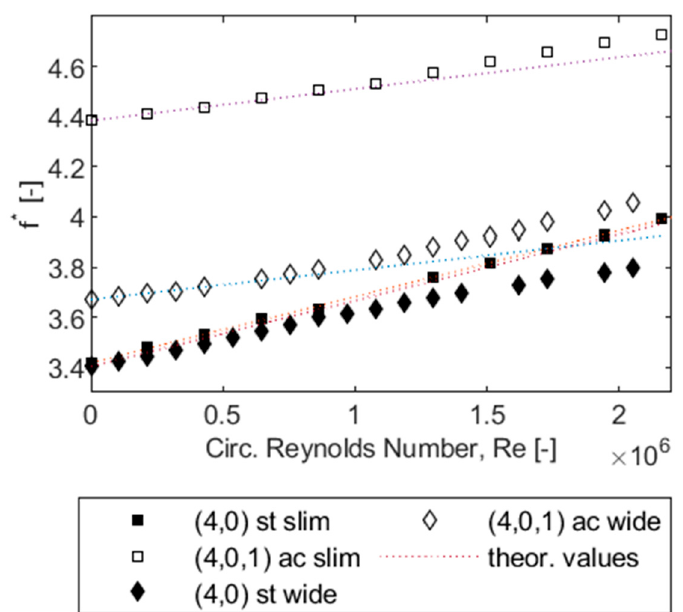
Figure 11. Normalized natural frequencies of forward waves of four nodal diameter mode pair in air at 0.1 MPa for “wide” and “slim cavity” over circumferential Reynolds number. Experimental and theoretical results (core rotation factors of 0.44 and 0.48 are adopted for the theoretic values of the acoustic waves for “slim” and “wide cavity” setup, respectively).